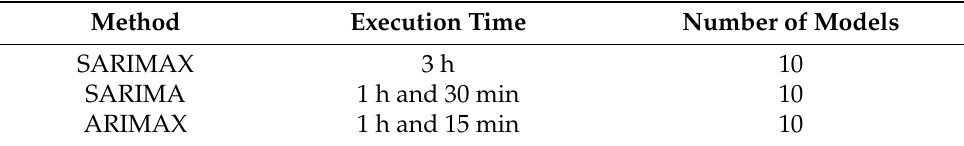
Table 2. Execution times of the three time-series methods for Step 3 of Phase